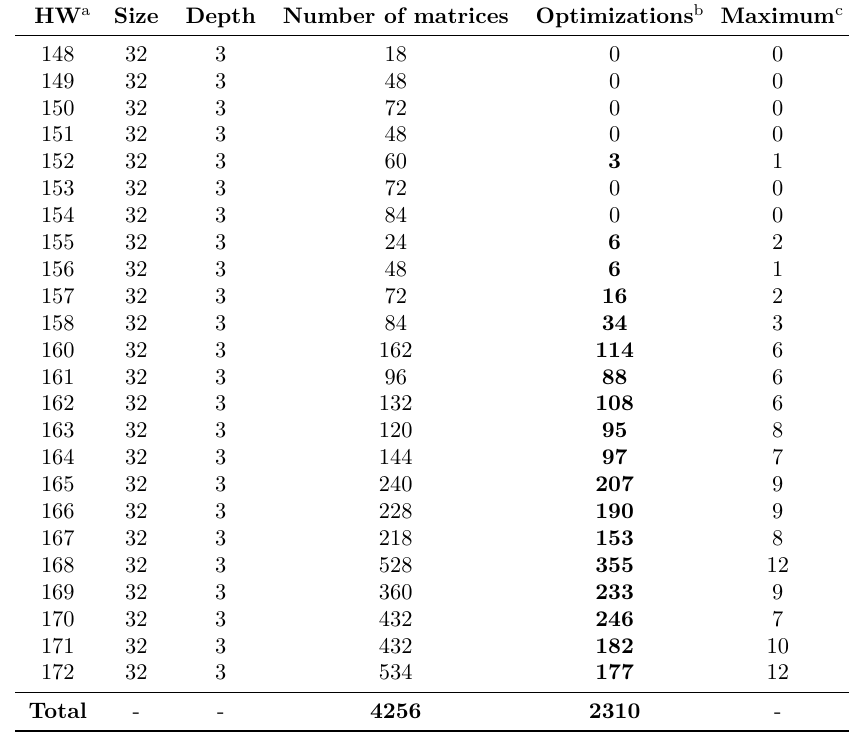
Table 8: The optimized results of matrices with depth limitation from [LSL + 19] HW a